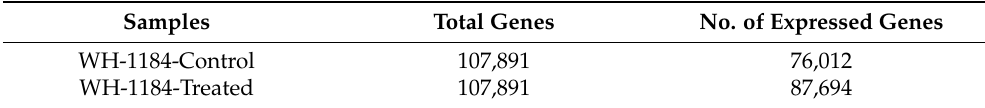
Table 4. Number of expressed genes in control and treated